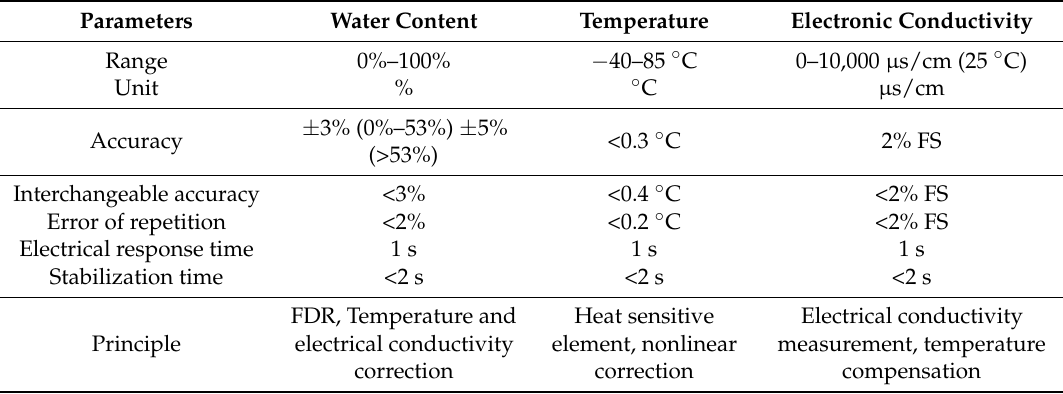
Table 2. Parameters of